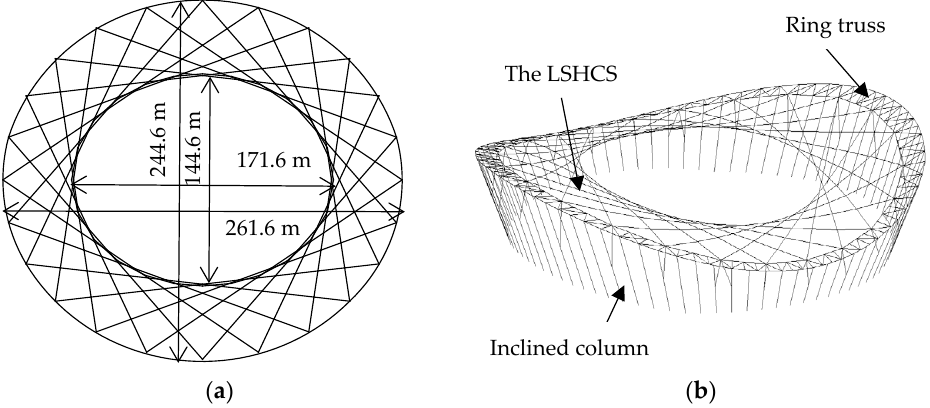
Figure 2. The original structure scheme of the LSHCS: ( a ) plane projection and ( b ) 3-D drawing.